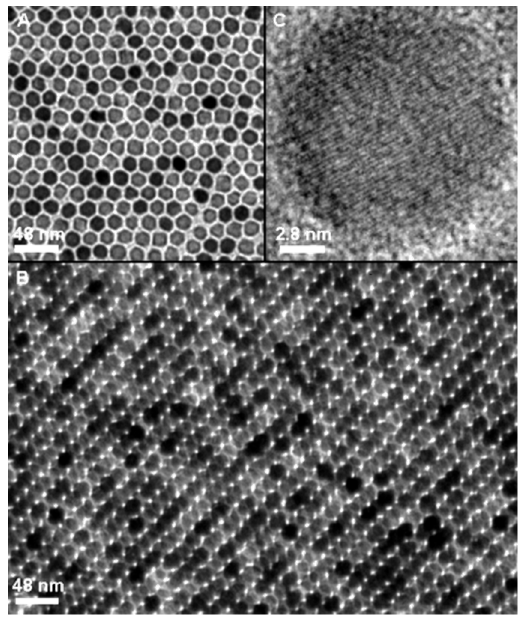
Figure 3. Transmission electron microscopy (TEM) images of IONPs synthesized by thermal decomposition. Reproduced with permission from Sun et al.